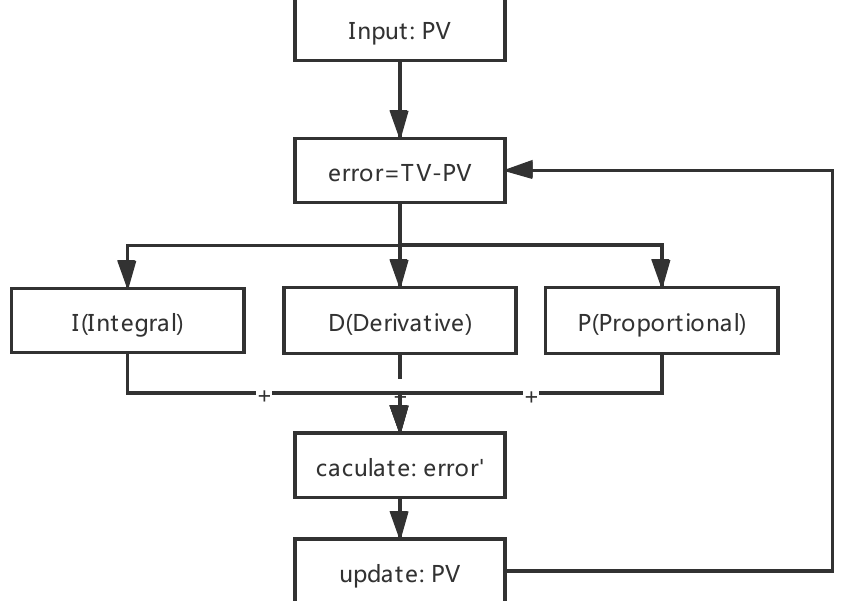
Figure 1. Flowchart of PID